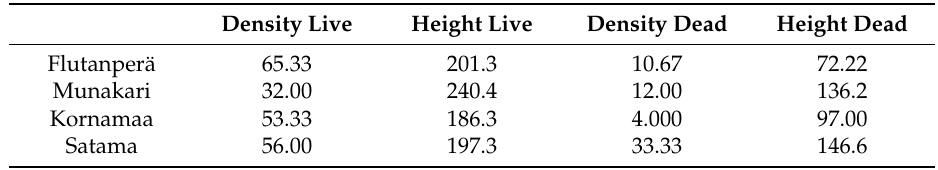
Table 2. The average density (pcs { m 2 ) and height (cm) of live and dead stems at Olkiluoto sites. Each value is the average of three measurement points. Density Live Height Live Density Dead Height